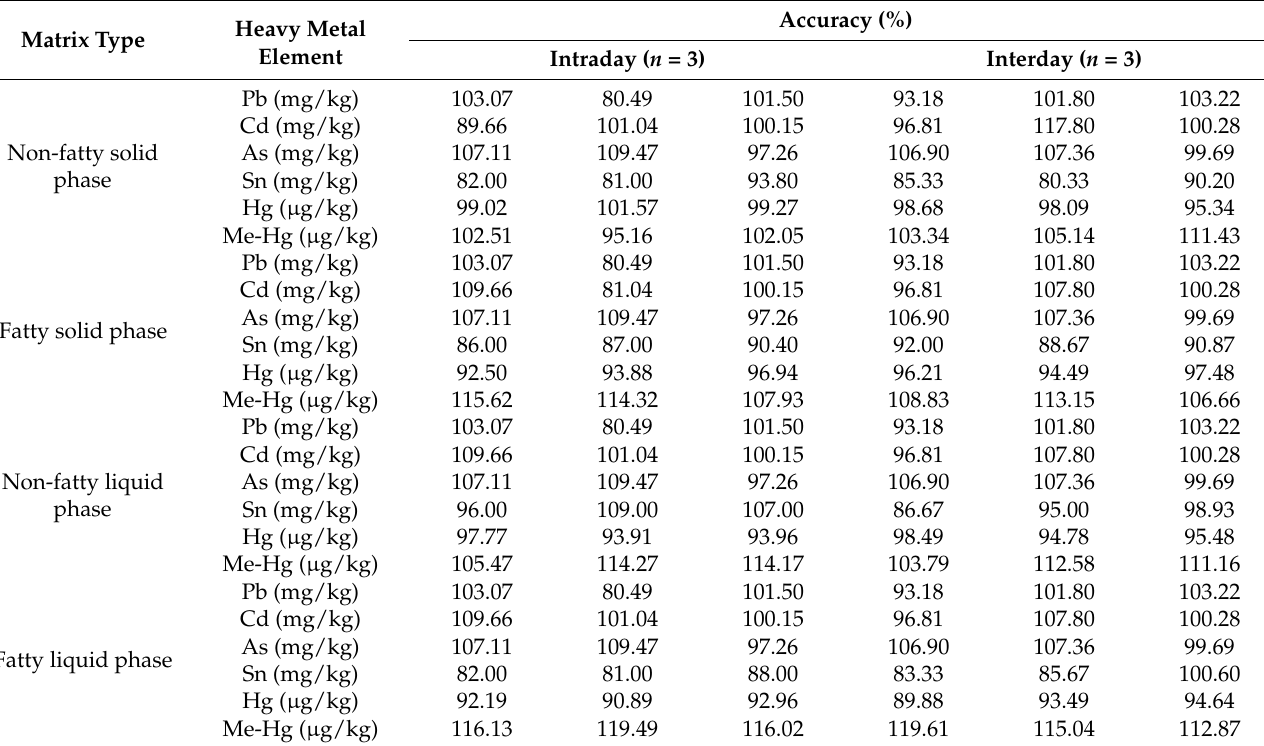
Table 2. Accuracy analysis of the six heavy metals.